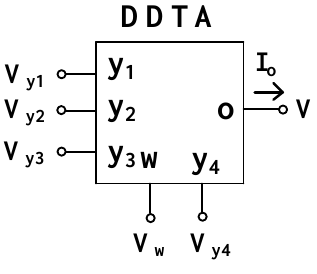
Figure 1. Symbol of DDTA.